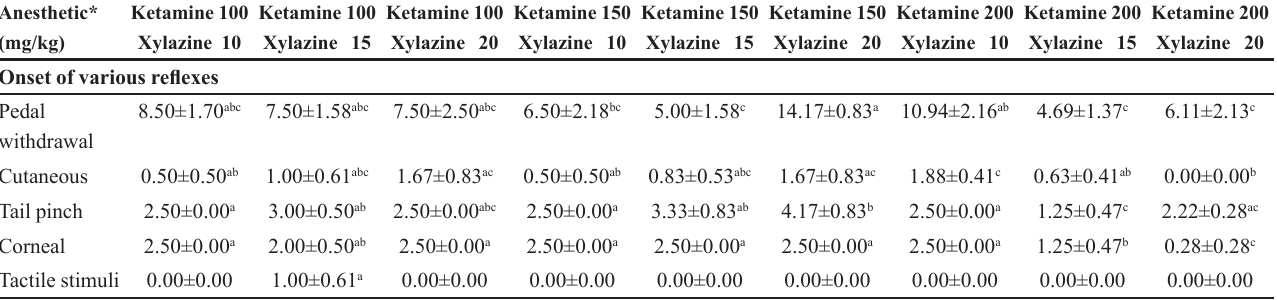
TABLE III - Comparison of onset of various reflexes of anesthesia using different doses of ketamine/xylazine in